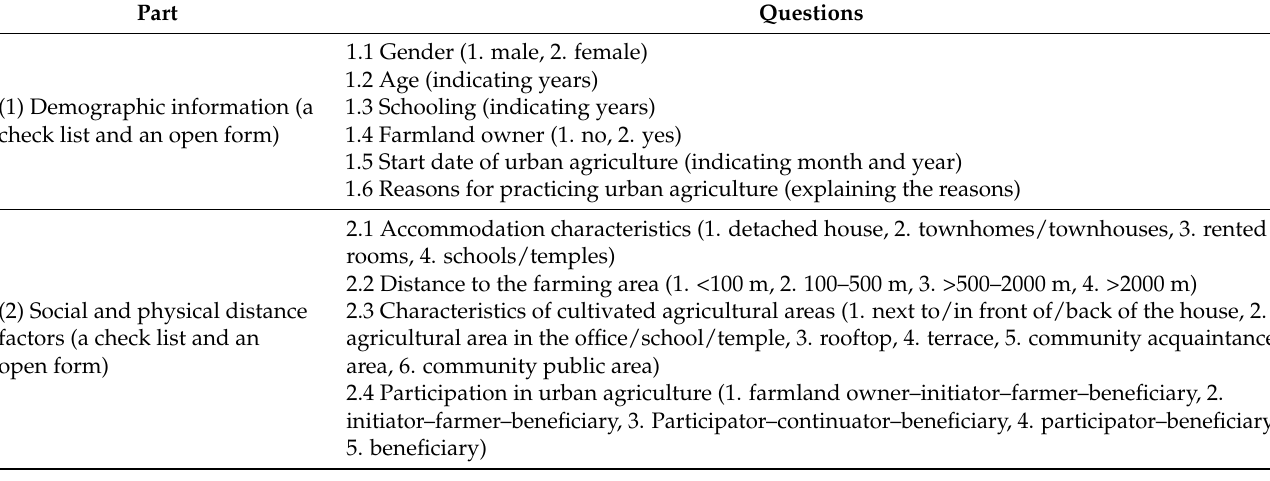
Table 2. The questions in the